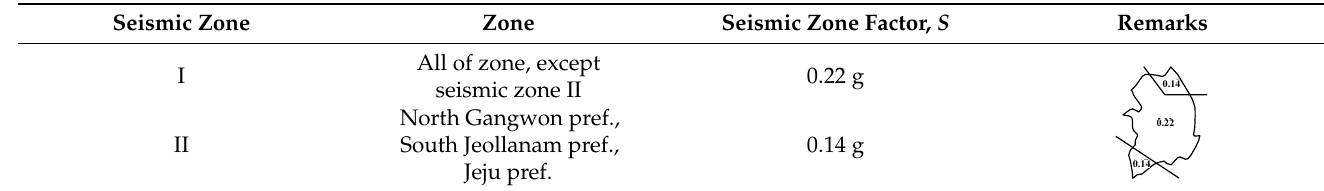
Table 5. Seismic zone factor corresponding to each zone. Seismic Zone